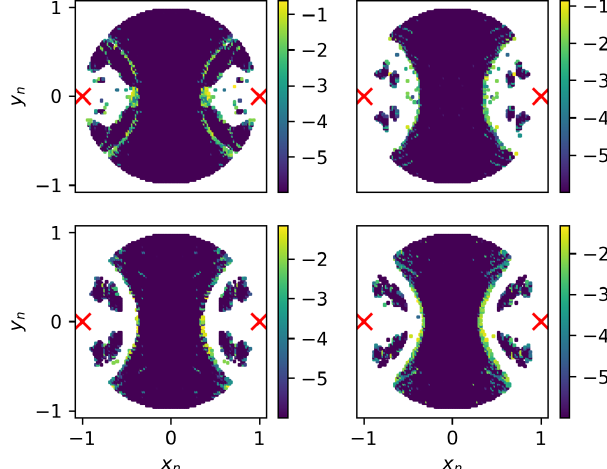
FIG. 15. Dynamic aperture plot of the IOTA toy-model using FMAwith a large number of turns T ¼ 65536 for each successive interval. The toy-model parameters are ν ¼ 0 . 3 , τ ¼ − 0 . 4 and δμ ¼ 0 . 01 for the left top, δμ ¼ 0 . 02 for the right top, δμ ¼ 0 . 03 for the left bottom and δμ ¼ 0 . 04 for the right bottom.